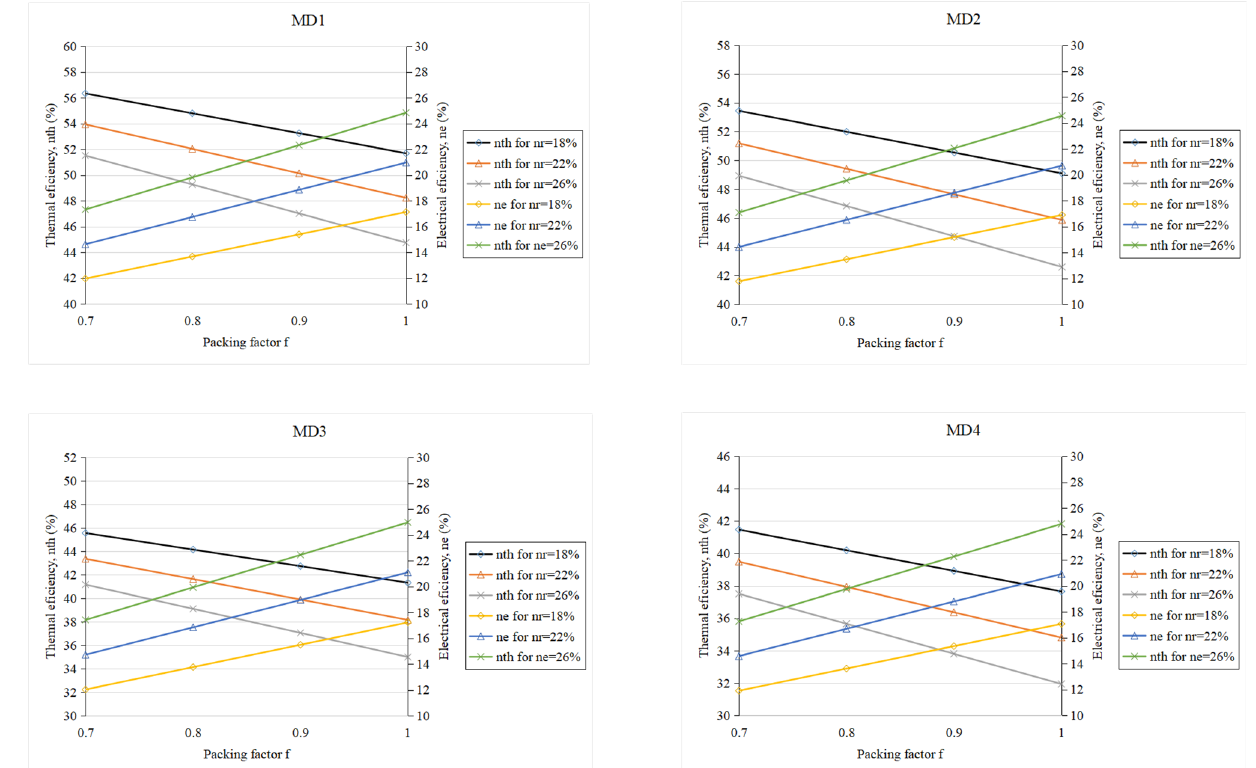
Figure 20. Thermal and electrical efficiency of four PV/T module models when changing the reference efficiency of PV cells and packing factor.